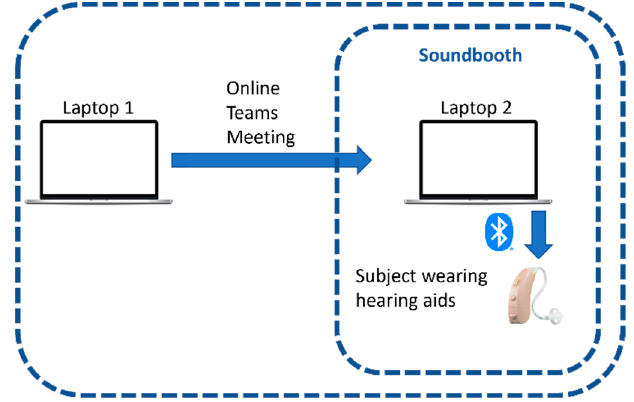
Figure 7. Experimental sound booth